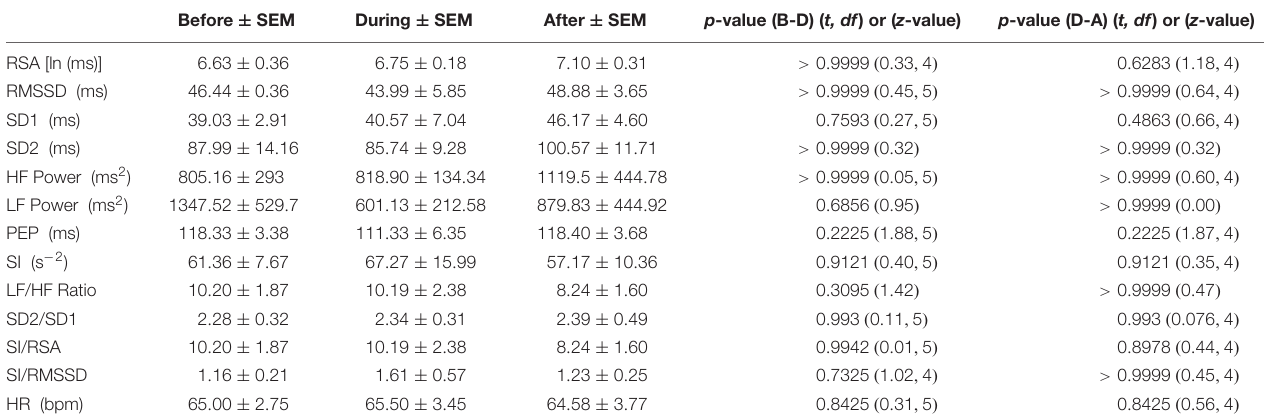
TABLE 3F | HRV parameters associated with HAPWs in response to proximal balloon distention ( n = 5). Before ± SEM During ±